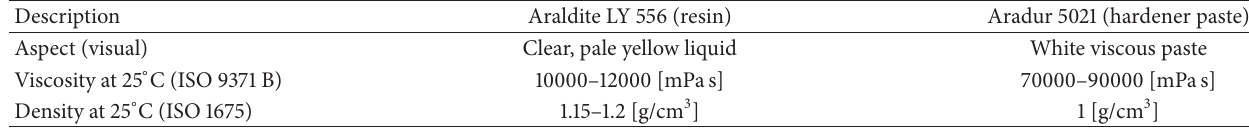
Table 5: Key data for Epoxy-Araldite LY 556 (resin).